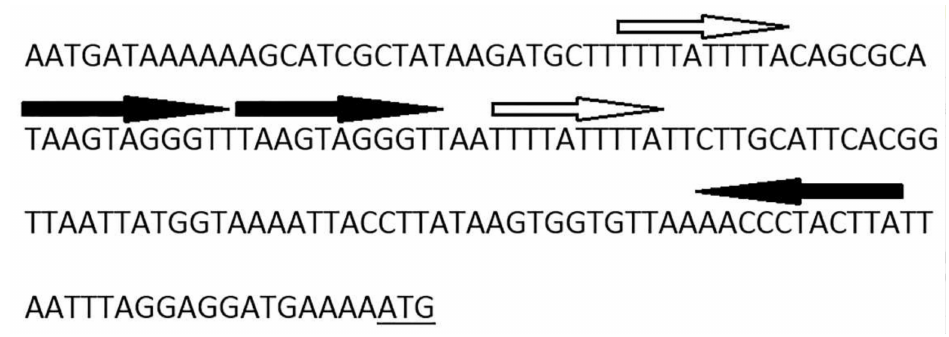
Figure 3. Nucleotide sequence of the region upstream of ORF32 showing the iterated sequences. The ORF32 start codon is